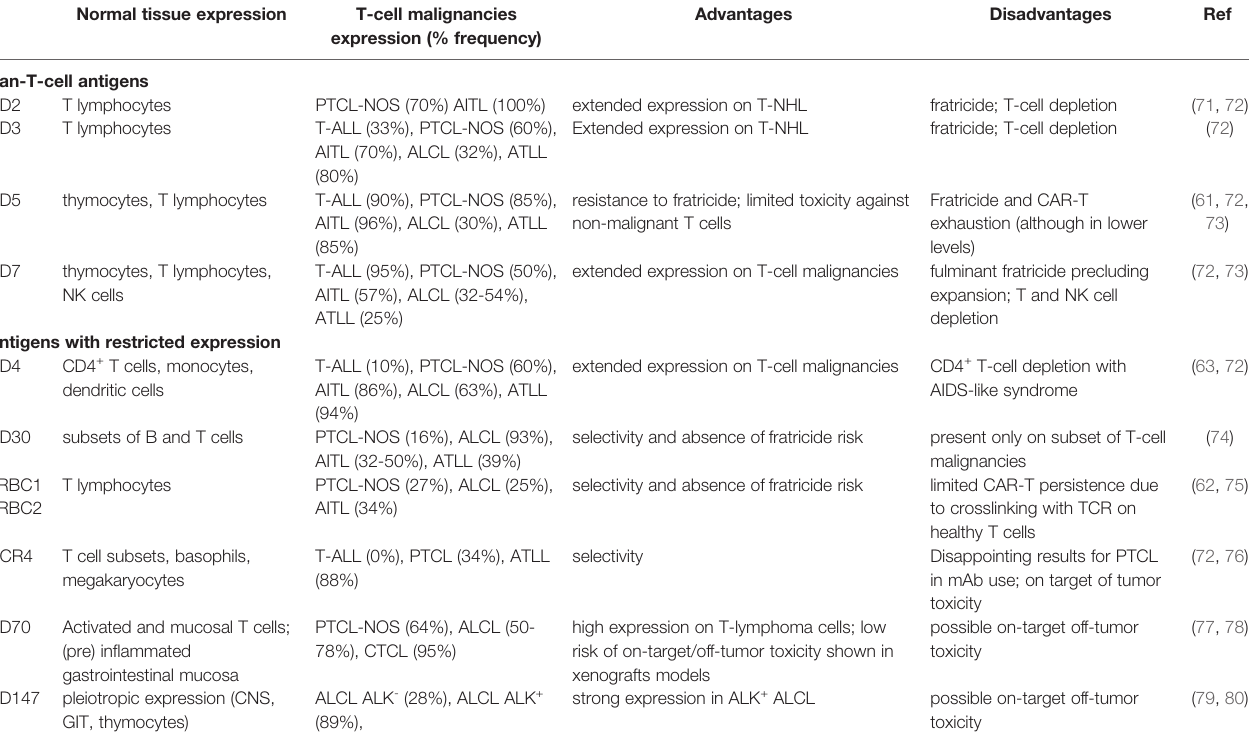
TABLE 2 | Selected antigens used to target T-cell malignancies with the main dis/advantages of their use. Normal tissue expression T-cell malignancies expression (% frequency)